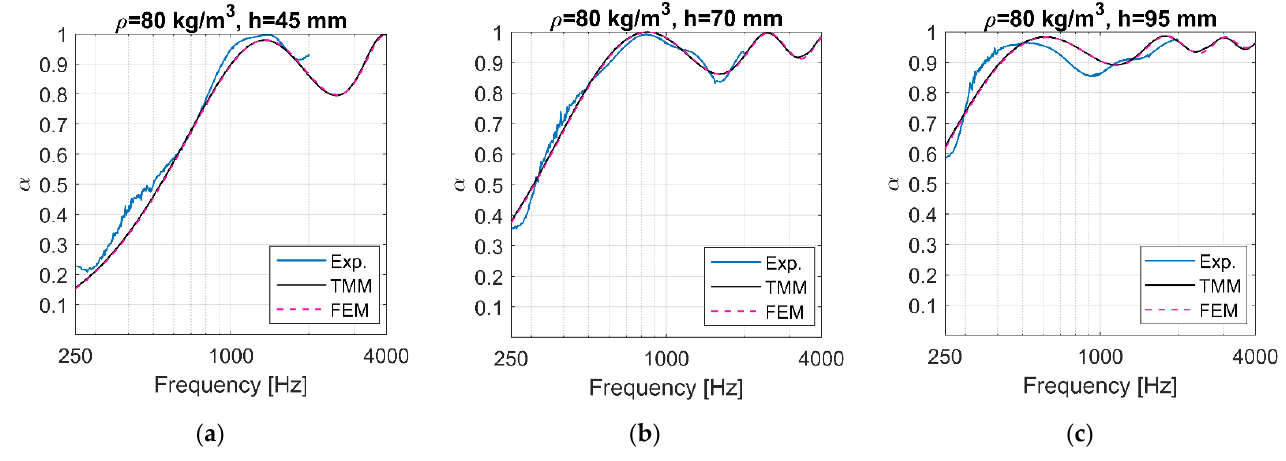
Figure 8. Comparisons between experimental results, TMM and FEM for RPU foams with ρ = 55 kg/m 3 .